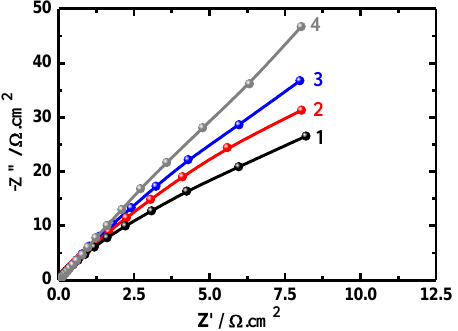
Figure 6. Nyquist plots for γ-TiAl alloy after (1) 0.0 h; (2) 1.0 h; (3) 4.0 h; and (4) 24 h immersion in 3.5% NaCl solution at room